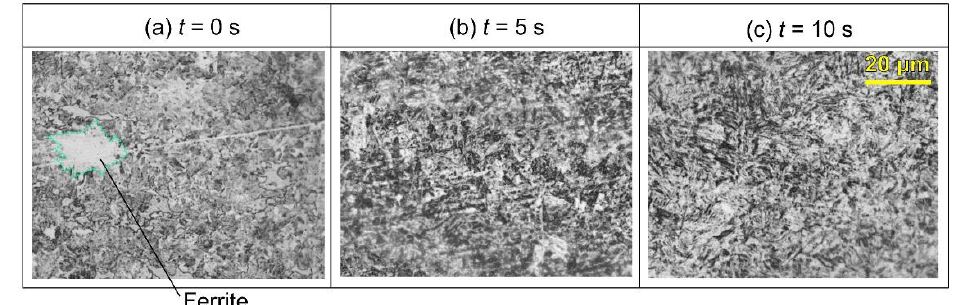
Figure 17. Microstructures of hot hat-shaped bent parts with and without holding at austenitising temperature for v = 275 °C/s and t = ( a ) 0 s, ( b ) 5 s and ( c ) 10 s.